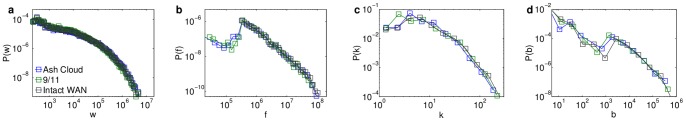
Network properties before and after natural disruptions.
(a–d) Relative frequencies of standard network measures: link weight , node flux , degree , and betweenness . The functional form of the probability distributions are largely unaffected by the events under consideration.